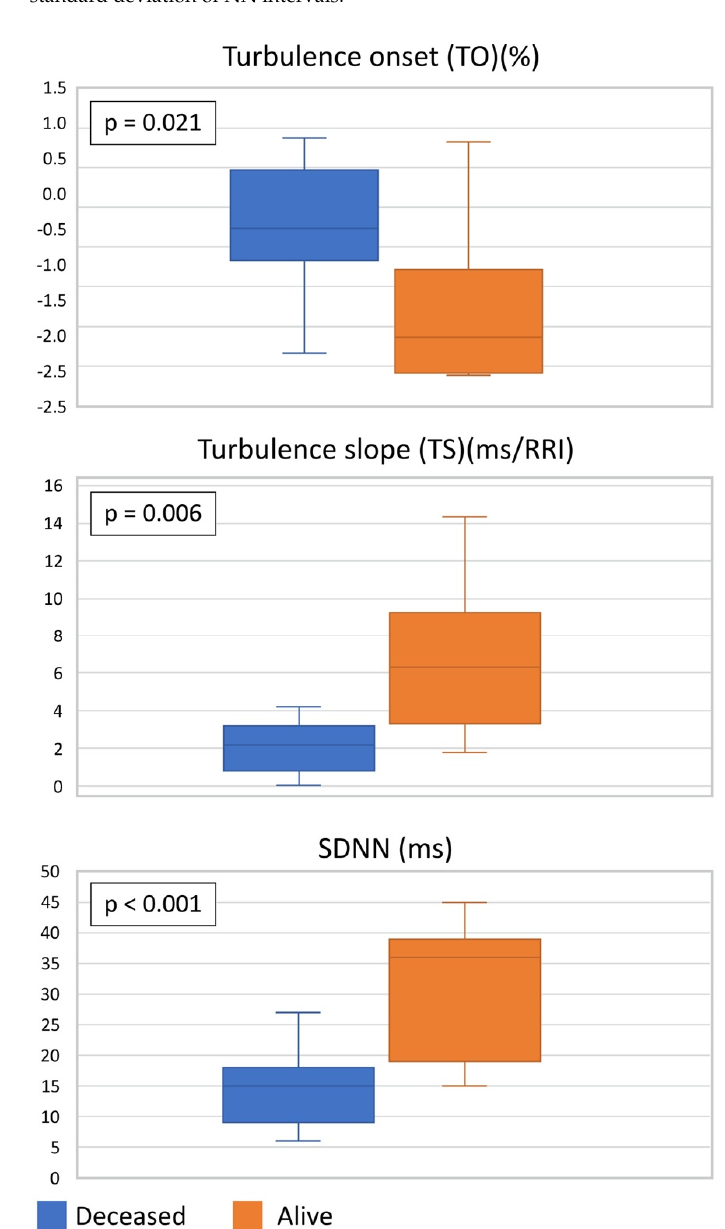
Figure 2. Summary of results. RRI: interval between two consecutive RR intervals; ms: millisecond; other abbreviations as in Table 2.